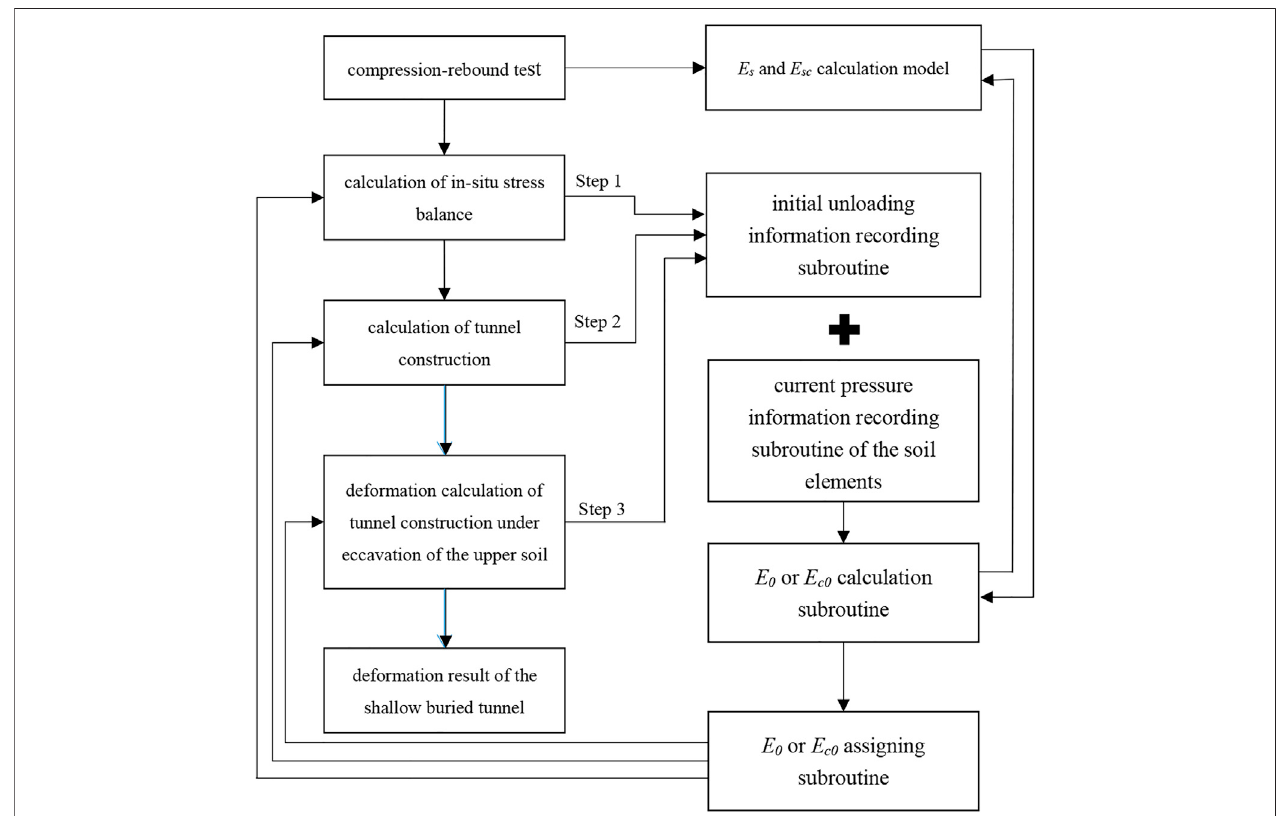
FIGURE 5 | Calculation process of the proposed